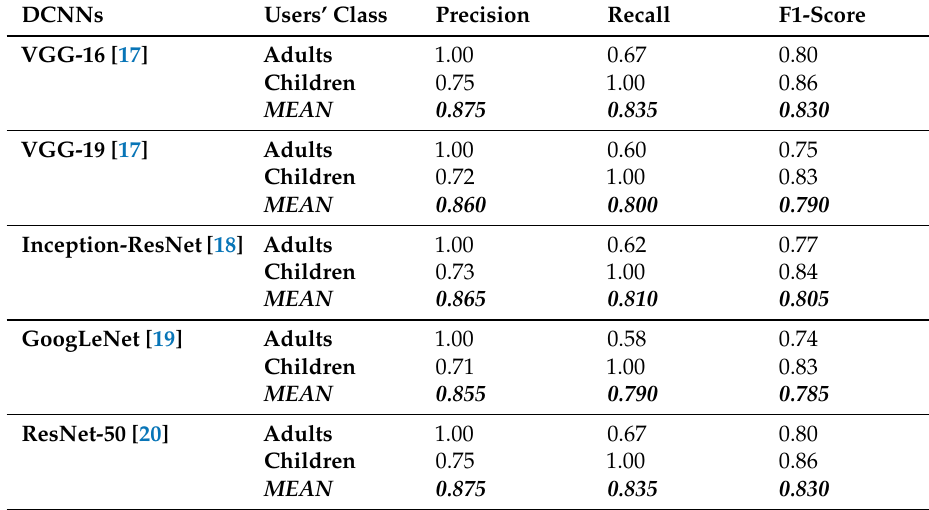
Table 2. Performance evaluation of the DCNNs for the users’ classification.